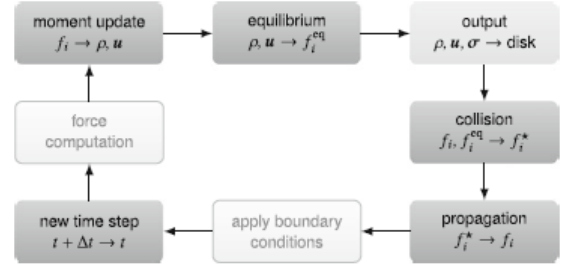
Fig. 1. Schematic illustration of the Lattice Boltzmann cycle, [10].